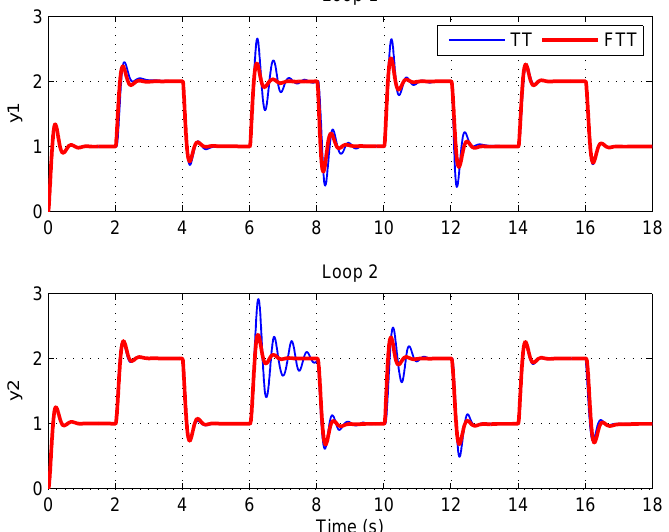
Figure 7. System output under slight interference.